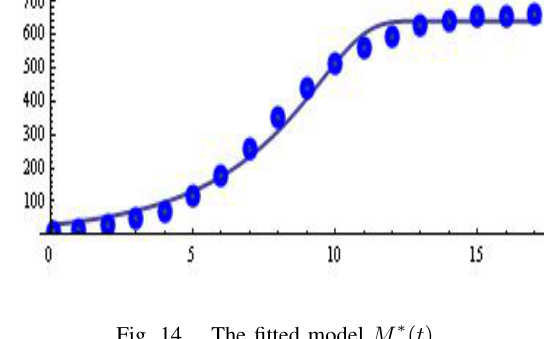
Fig. 14. The fitted model M ∗ ( t )